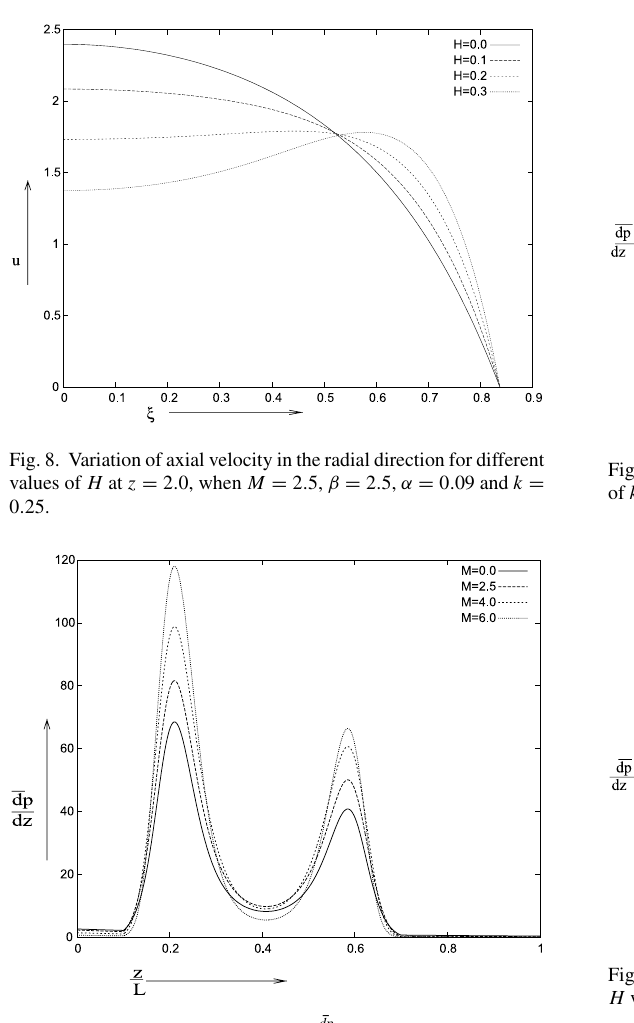
Fig. 9. Variation of pressure gradient ( when H = 0 . 2, β = 2 . 5, α = 0 . 09 and k = 0 . 25.